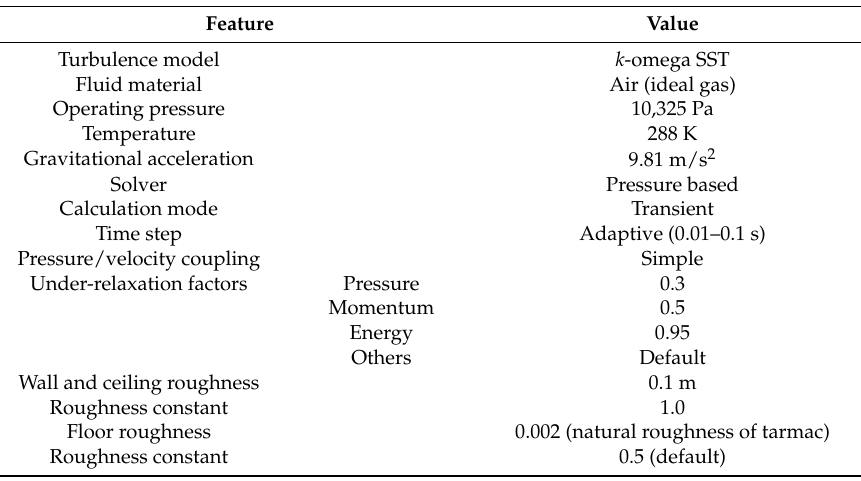
Table 1. Numerical model